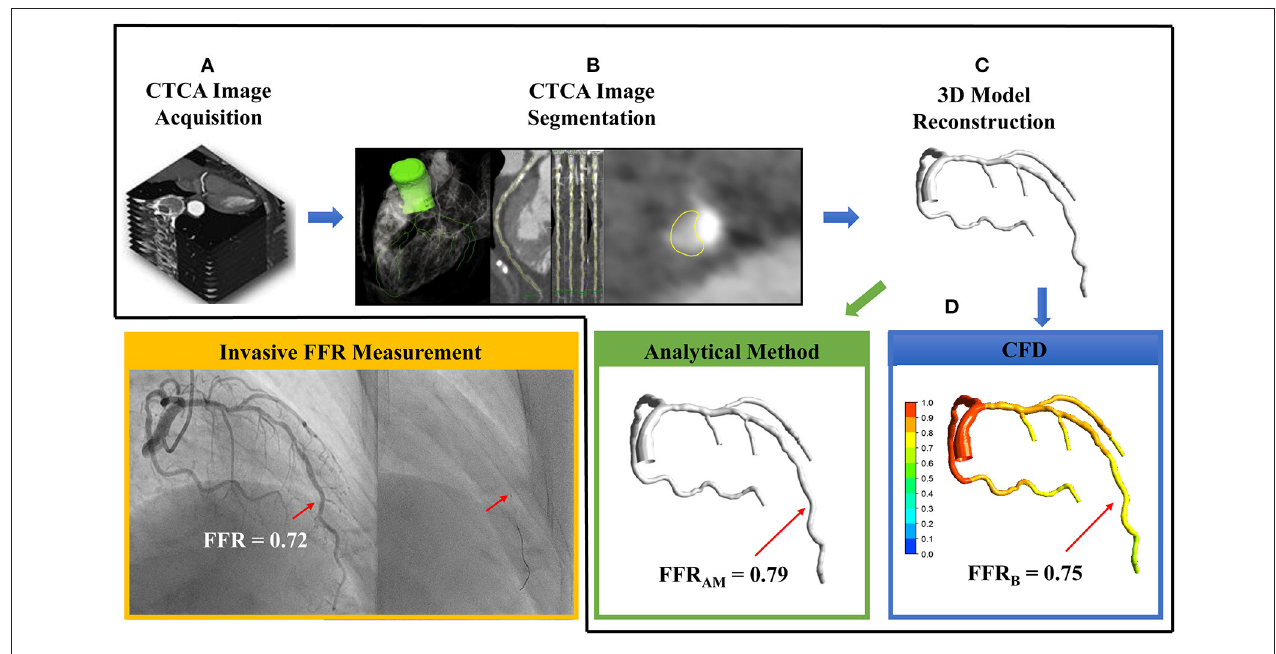
FIGURE 2 | The sequential steps involved in the calculation of non-invasive fractional flow reserve (FFR) include (A) computed tomography coronary angiography (CTCA) image acquisition, (B) CTCA image segmentation via extracting centerlines and delineating lumen contours in the transversal and cross-sectional images, (C) 3D reconstruction of subject-specific coronary artery tree, and (D) using either analytical method to calculate FFR AM (green box) or computational fluid dynamics simulation to compute FFR B (blue box). In this case, FFR AM and FFR B were 0.79 and 0.75, respectively, at the site of invasive FFR 0.72 measured with a pressure catheter (right, inset) during invasive coronary angiography (yellow